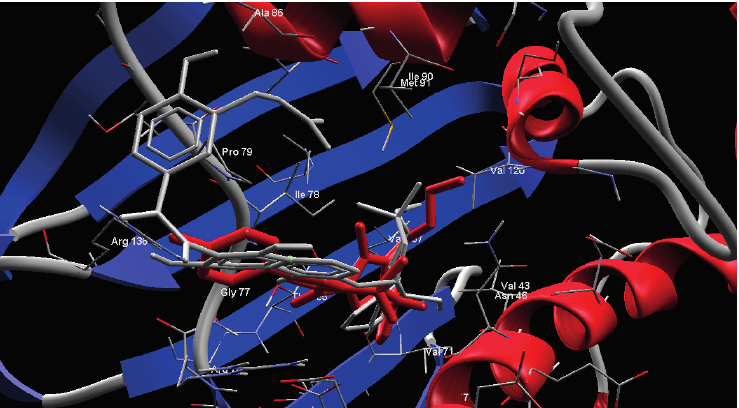
Figure 4. Superimpose of the co-crystallized clorobiocin ( Gray ) and compound 9f ( Red ) in the active site of the E. coli 24 kDa domain.